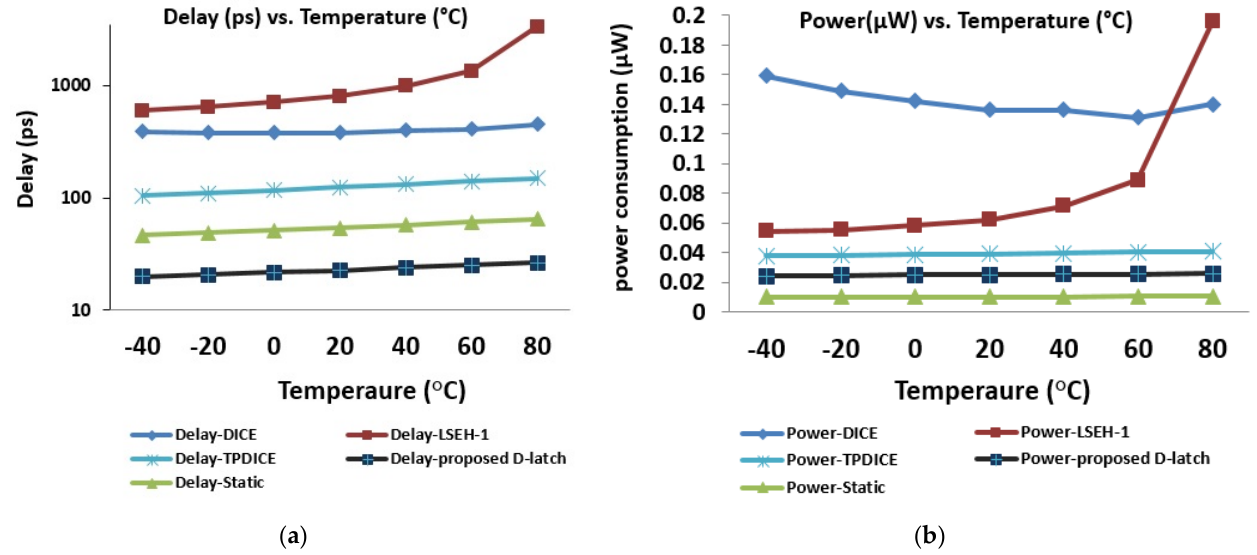
Figure 10. Temperature variation effect on: ( a ) delay vs. temperature; ( b ) power consumption vs. temperature.